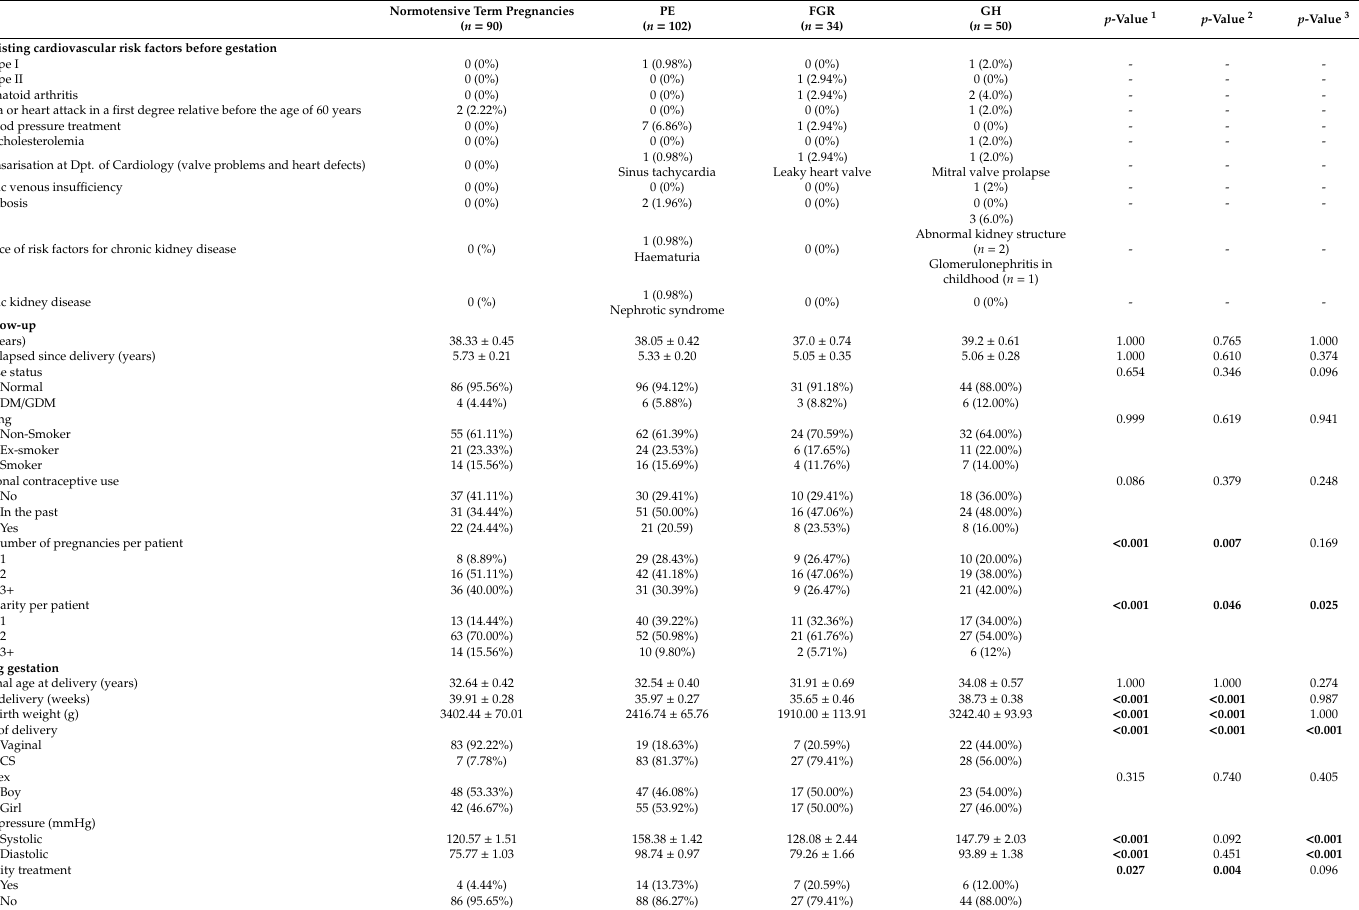
Table 1. Characteristics of cases and